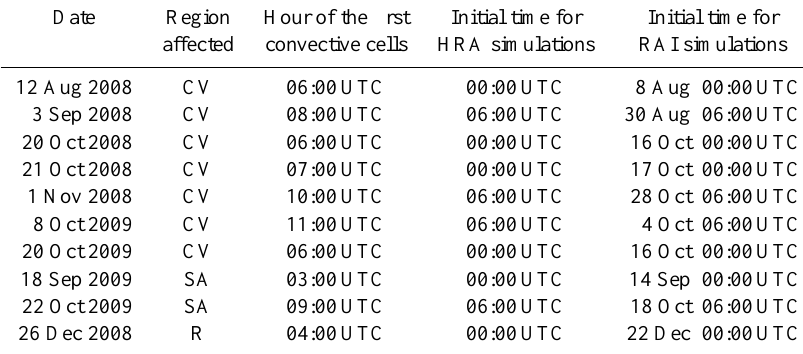
Table 1. The HPE cases. For the region affected by the HPEs, CV stands for the C´evennes-Vivarais region, R for Roussillon and SA for Southern Alps (see Fig. 2 for their geographical